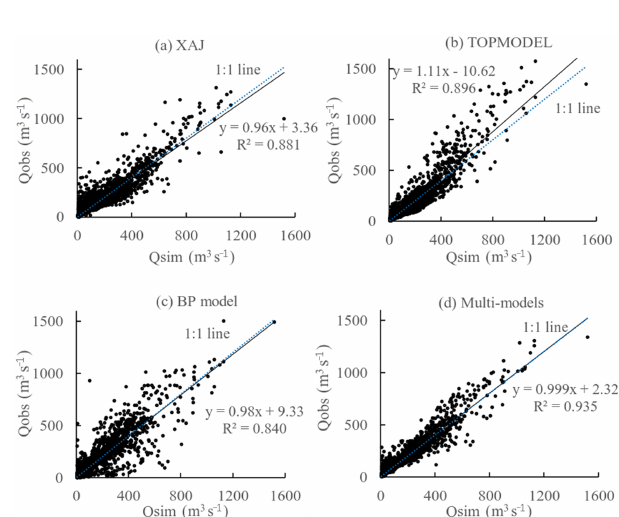
Figure 8. Comparison of the observed and simulated runoff of